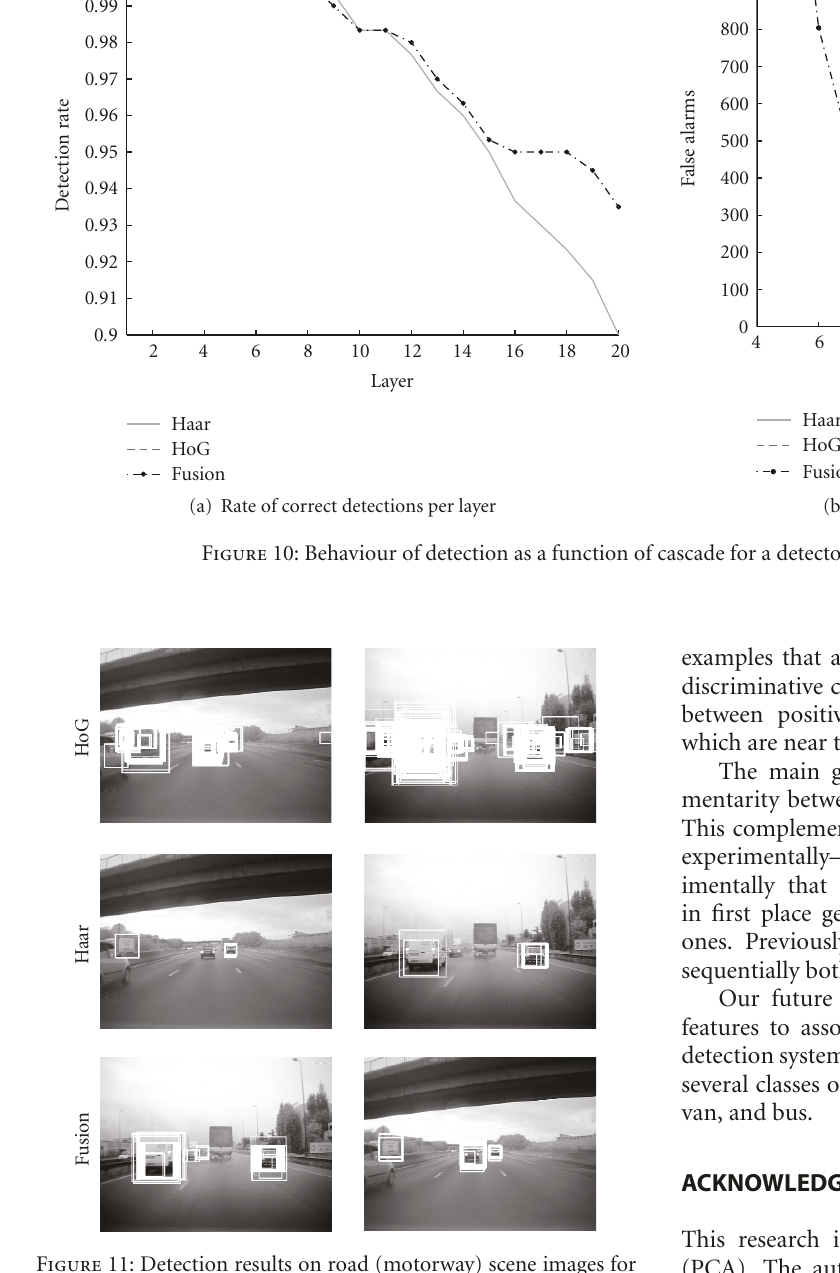
Figure 11: Detection results on road (motorway) scene images for three types of